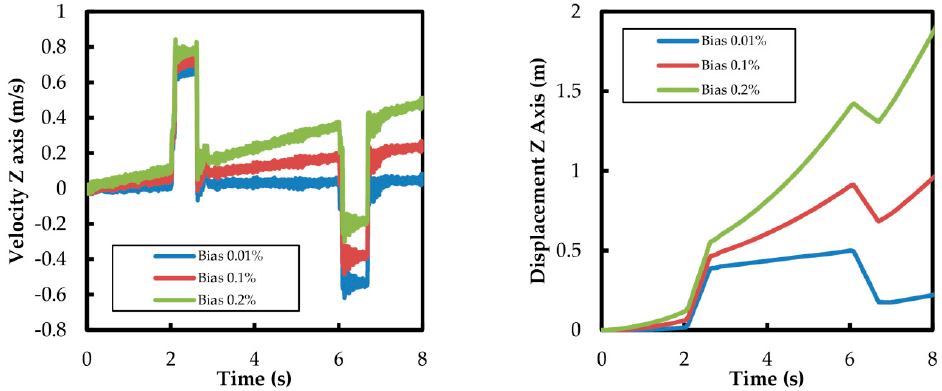
Figure 11. Calculated velocity and displacement for Z axis; Bias error evaluation.